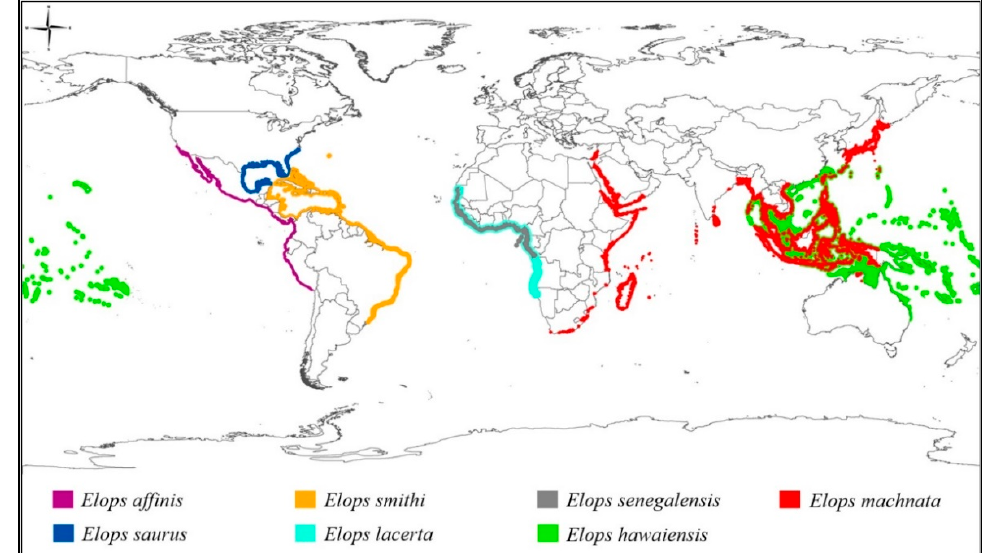
Figure 1. Geographical distribution map of Elops species by Adams et al. [1]. Table 1. Data used as diagnostic characters for Elops species, in studies by different authors. Number of